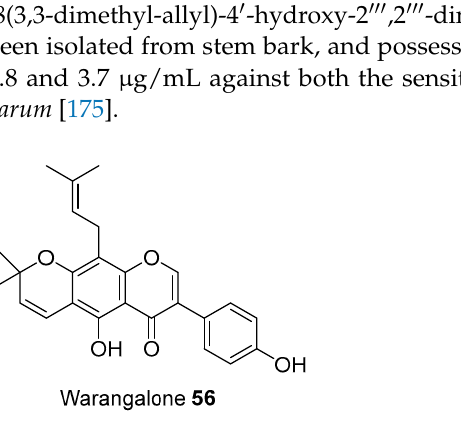
Figure 10. Antimalarial compound of plants used by Tenggeresse (isolated from same species grown in other